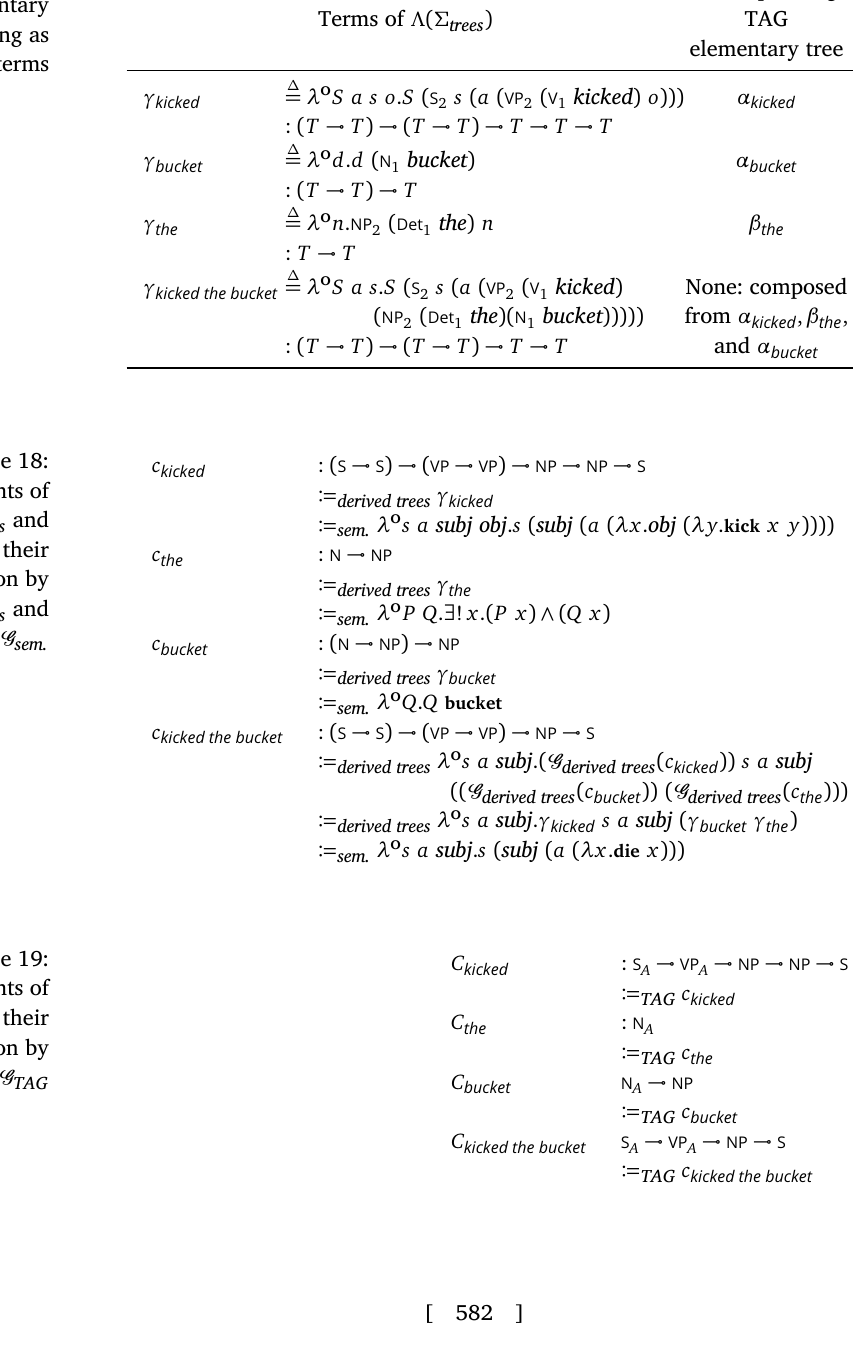
Terms of (cid:3)((cid:6) trees ) TAG